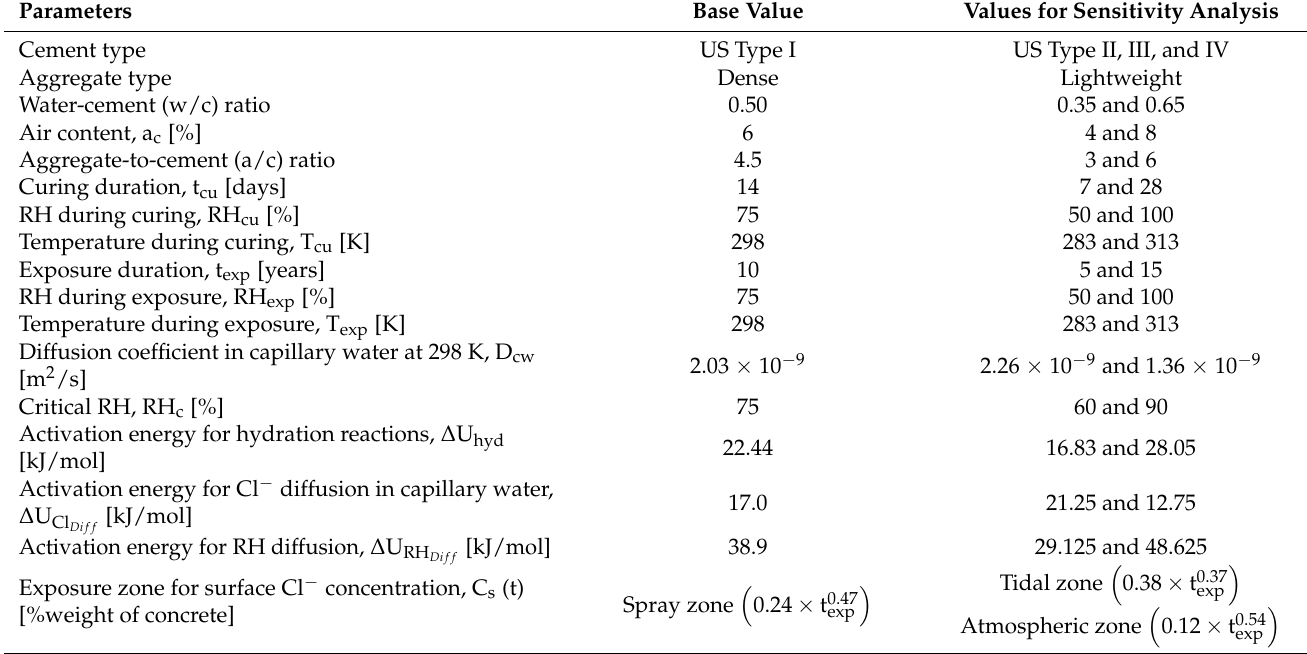
Figure 5. Comparison of results from model and analytical solution of ( a ) temperature in case 1, ( b ) RH in case 2, ( c ) Cl − in case 3, and ( d ) O 2 in case 4. Table 3. List of parameters and their values for sensitivity